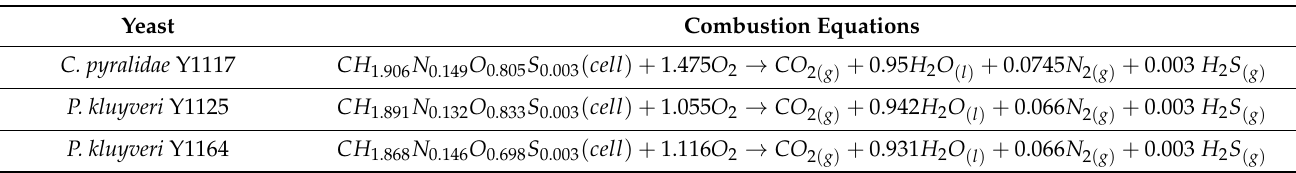
Table 7. The combustion equations used for the calculation of energy requirements during biochemical conversion of substrate for growth and secondary metabolite production (biopreservatives) by C. pyralidae Y1117, P. kluyveri Y1125, and P. kluyveri Y1164 using grape pomace extract as fermentation